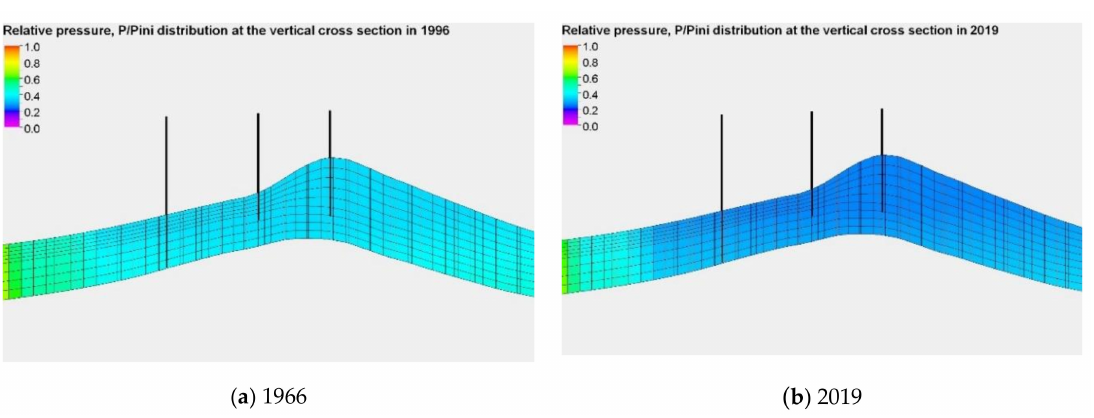
Figure 23. Relative pressure distribution along the vertical cross section connecting wells: W29, W22, W11.